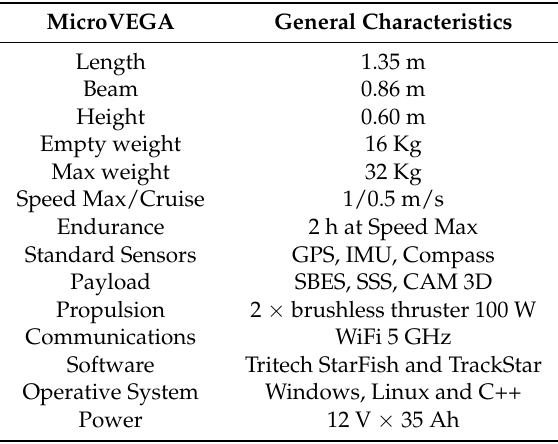
Figure 7. Dimensions (cm) of MicroVeGA catamaran. Table 1. General characteristics of MicroVeGA